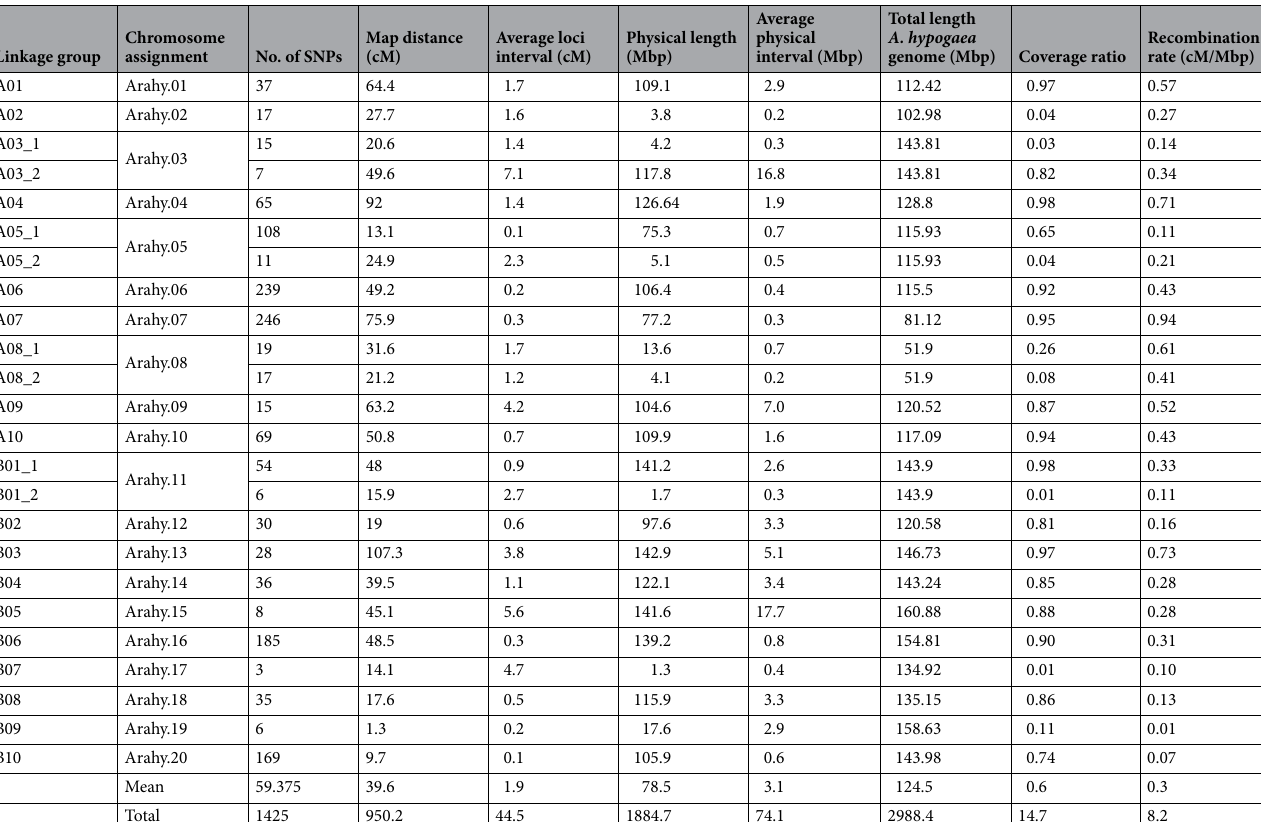
Table 3. Description of genetic linkage groups. Physical distance was determined by BLAST alignment of markers against the A. hypogaea reference genome (version 2) (peanutbase.org).